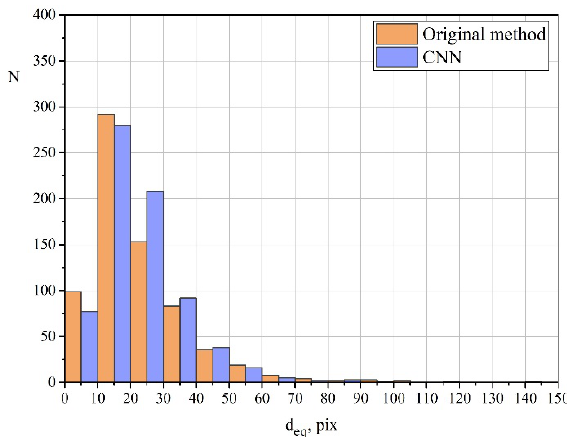
Figure 9. Diagram of the distribution of equivalent diameters, calculated using the original method [22] and the proposed CNN.